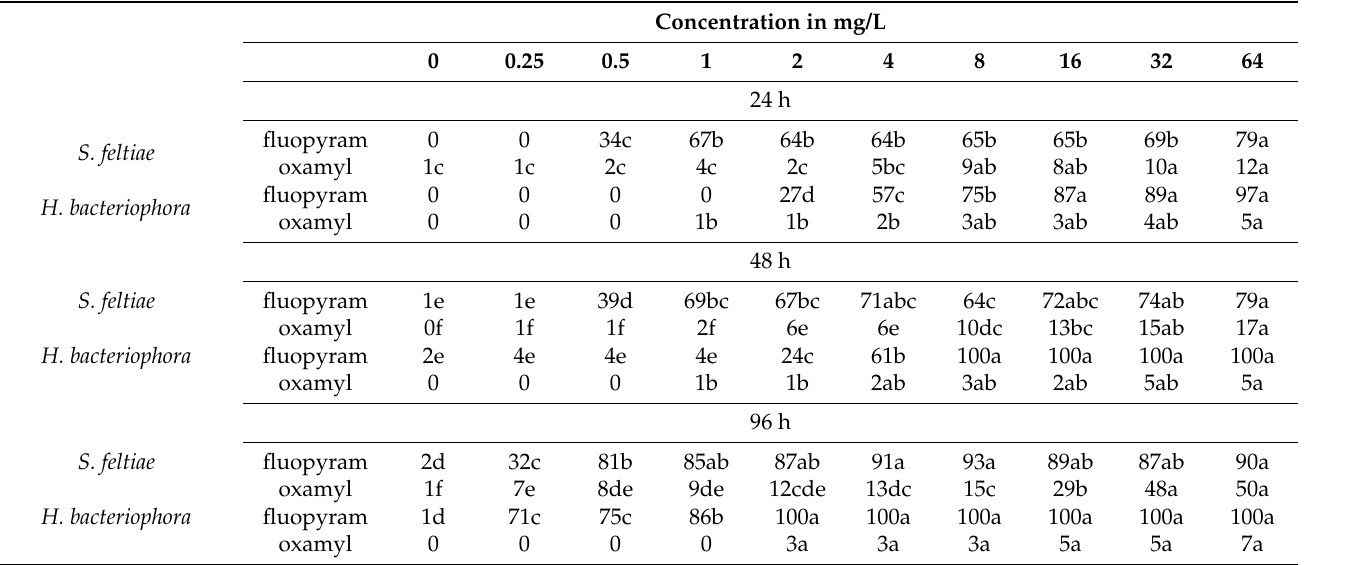
Table 1. Percentage of dead third-stage instars of Steinernema feltiae and Heterhorhabditis bacteriophora when affected by different concentrations of fluopyram or oxamyl after 24, 48, and 96 h of incubation with 50 third-stage instars per treatment well. Numbers in the same line followed by the same lowercase letters are not significantly different at p <